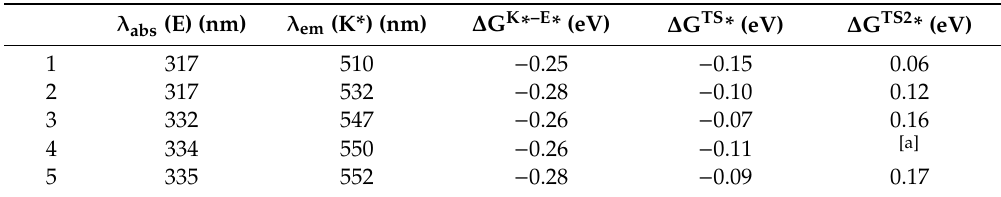
Table 3. Computational results for HBO dyes 1 – 5 in toluene. The vertical absorption wavelength of the enol form and the vertical emission wavelength of the keto forms are reported as well as the di ff erence of free energies on the excited-state potential energy surface (in eV).